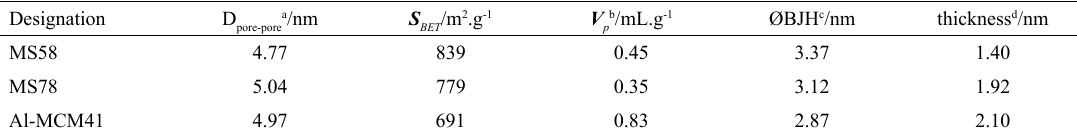
Figure 3. Nitrogen adsorption-desorption isotherms at 77K of calcined samples MS58, MS78 and Al-MCM4. Inset: Pore size distribution (PSD) obtained by BJH method applied on desorption branch. Table 1. Textural and structural parameters of material samples calcined at 823 K under air for 6